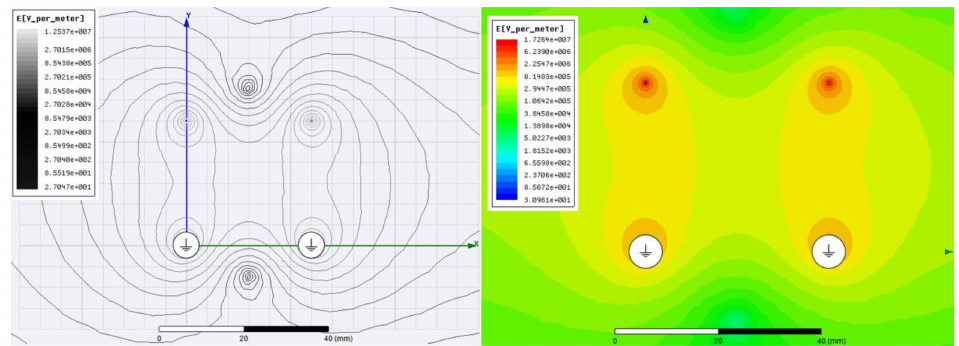
Figure 11. Dual thruster, electric field distribution (absolute value of